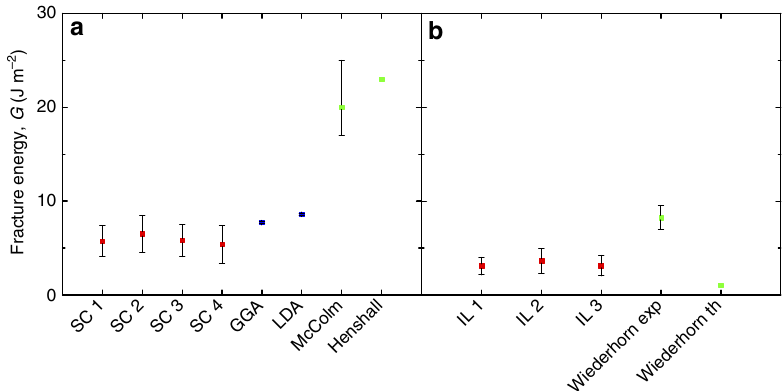
Fig. 6 Comparison of data obtained in current work from experiments and DFT with existing literature on macroscopic tests. Data from current experimental work are measured as the average, while the error bar represents the standard error of mean, both as obtained from the Monte Carlo-based error propagation analysis (see Methods). Data from literature (McColm 37 , Henshall 38 , and Wiederhorn 26 ) are represented as mean value, while the error bar represents the scatter. a Comparison of fracture/surface energy data from microscopic and macroscopic experimental testings and DFT calculations of 6H-SiC (0001) plane; b comparison of fracture energies measured on glassy interlayer of SiC bi-crystals with values obtained on glass from macroscopic tests and theoretical